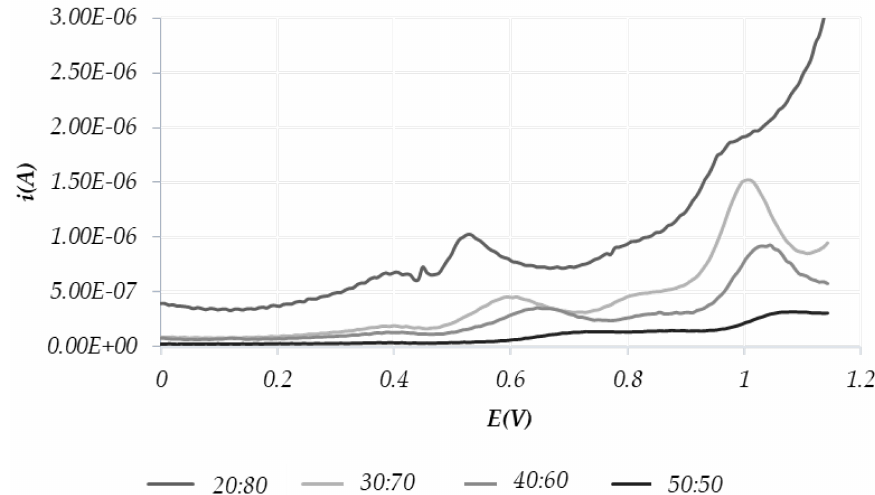
Figure 3. SWV scans recorded varying the oil:graphite ratio in the